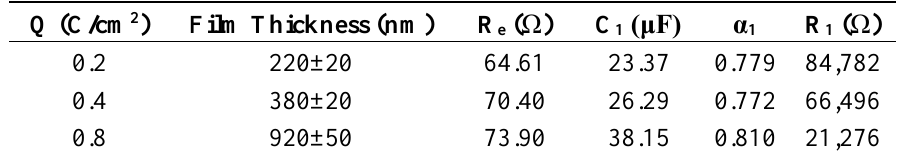
Figure 3. Nyquist plot (recorded at −0.5 V vs. ref.) of nanoporous SnO 2 /ITO electrodes with increasing film thicknesses from 220 ± 20 to 940 ± 50 nm. The filled symbols correspond to experimental data and the continuous lines to fitting data. The inset shows a zoom-in of the impedance curves at high frequency region. Table 2. Electrical parameter values obtained from fitting of Nyquist plot of bare nanoporous SnO 2 electrodes with increasing film